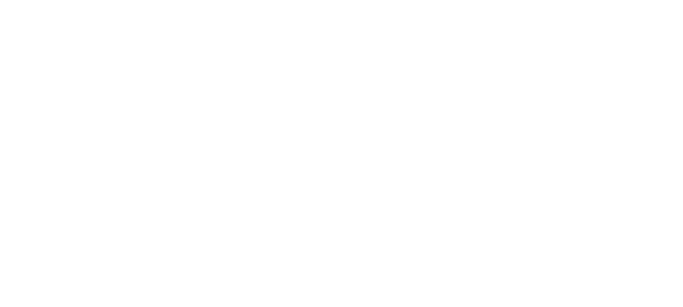
Table 2. Thermal properties of D, A and D/A